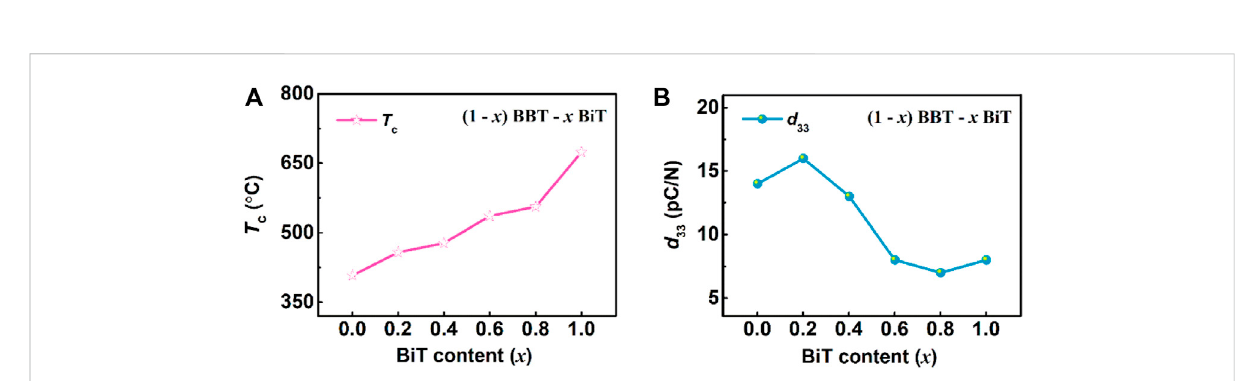
FIGURE 6 (Coloronline)ThevariationofCurietemperature T c ,piezoelectricconstant d 33 ,coercive fi eld E c andremnantpolarization P r for(1- x )BBT — x BiT ceramics with different BiT content ( x ): (A) T c , (B) d 33